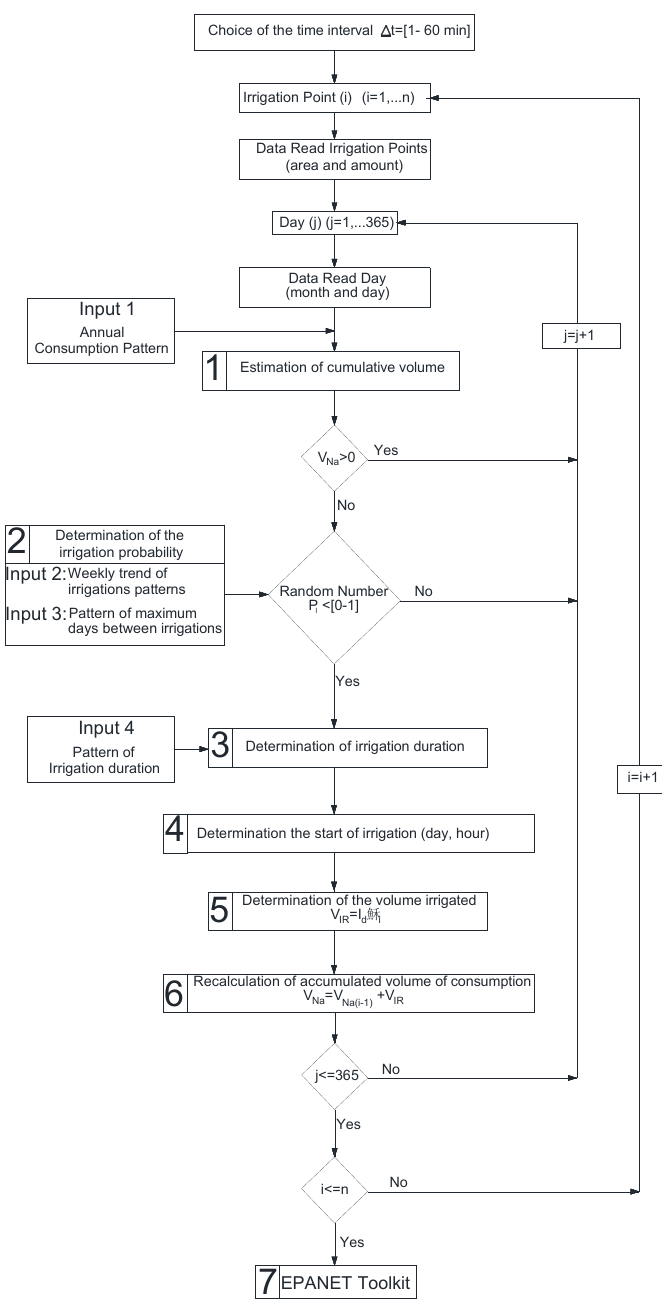
Figure 1. Schematic description of the methodology for flow estimation.